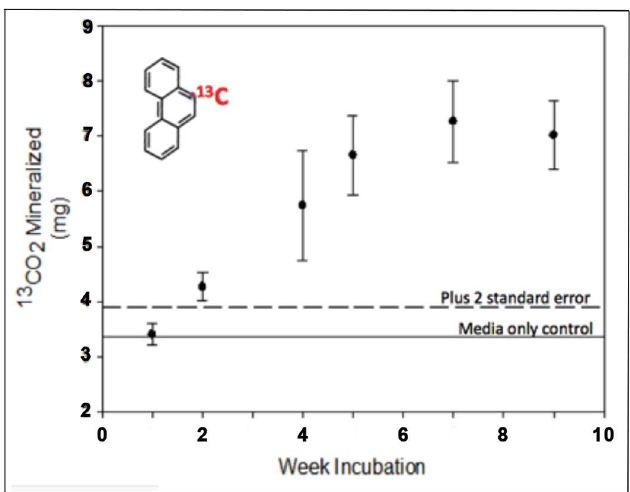
Fig 7. Trichoderma harzianum TSTh20-1 (TSTh) metabolized 13 C-phenanthrene to 13 CO 2 under micro- aerobic conditions. After two weeks growth and for more than nine weeks, TSTh generatedseveral-fold more 13 CO 2 than the media-only control treatment (solid line) or that plus two standarderrors (dashedline).